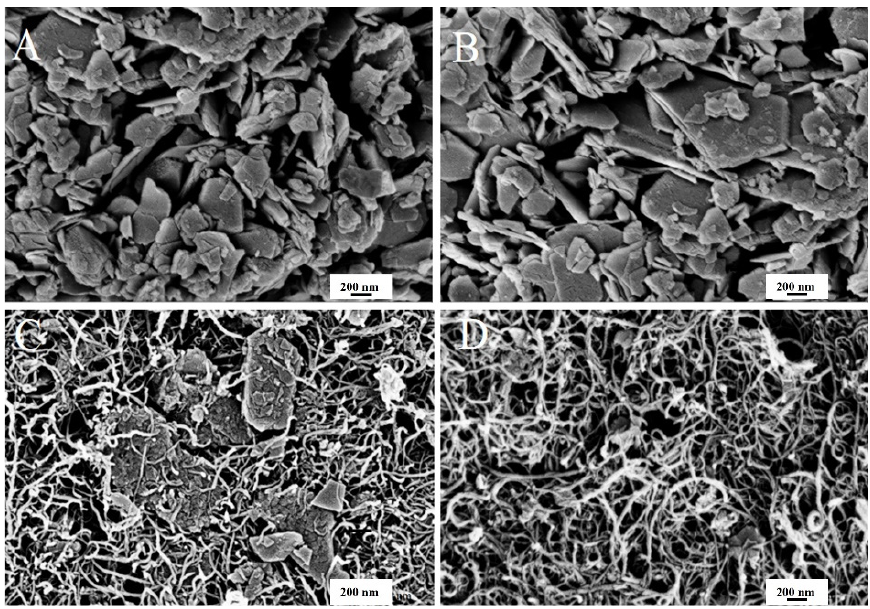
Figure 5. SEM images. ( A , B ) ZnO − NPs and ( C , D ) CNTs/ZnO composite. Table 1. ZOI range of ZnO − NPs and CNTs/ZnO on bacterial species. Bacterial Specie